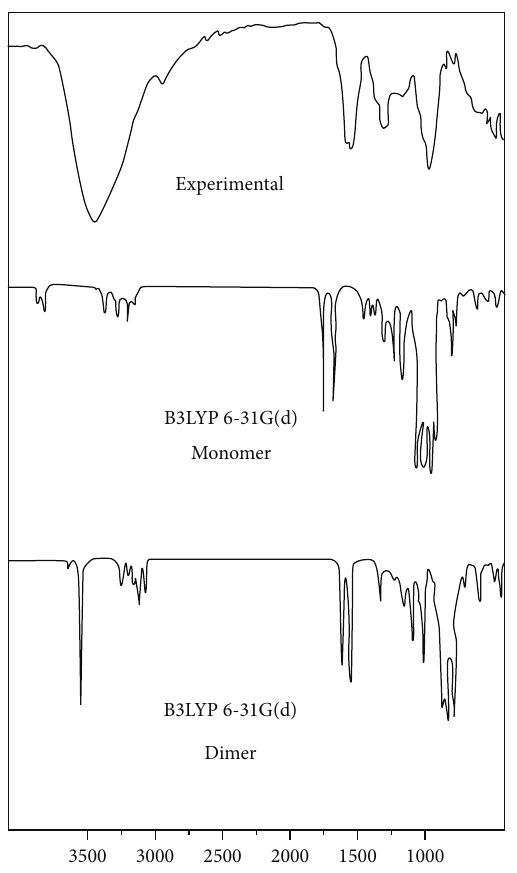
Figure 7: Experimental IR spectrum (top), theoretical B3LYP 6- 31G(d) strictosidine monomer (middle), and theoretical B3LYP 6- 31G(d) (bottom) strictosidine dimer IR spectra, in cm −1 .